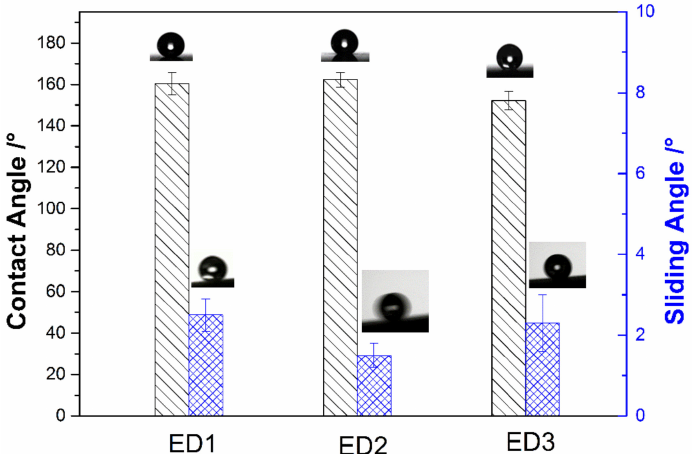
Figure 3. The contact angles and sliding angles of different electrodeposited coatings; ED1 means one-step electrodeposited surface with SiC particles, ED2 means two-step electrodeposited surface with SiC particles, ED3 means one-step electrodeposited surface without SiC